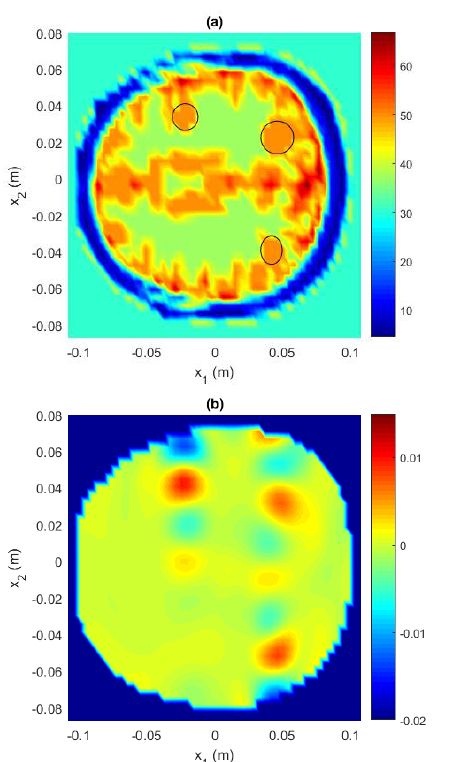
Figure 6: (a) Real parts of relative dielectric constant of 2-D head model with blood regions, (b) Detection of blood regions (Real parts of 𝛿𝑣